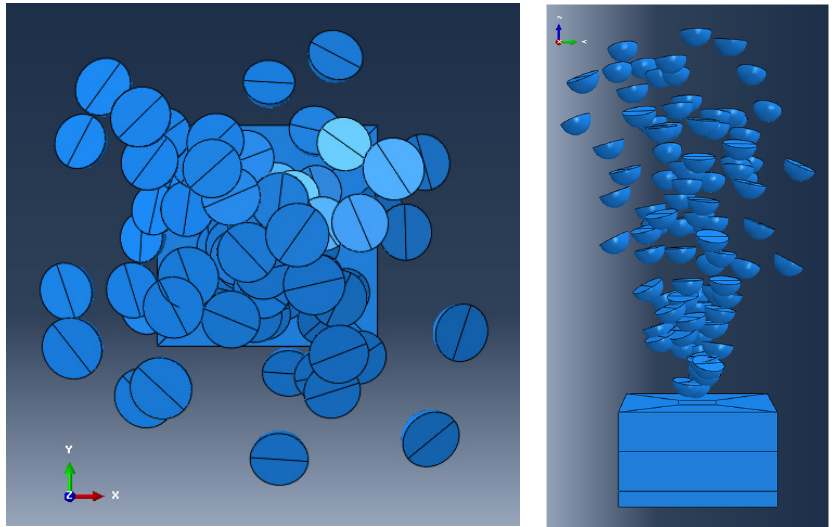
Figure 4. The top and side view of the randomly positioned multiple impact model.